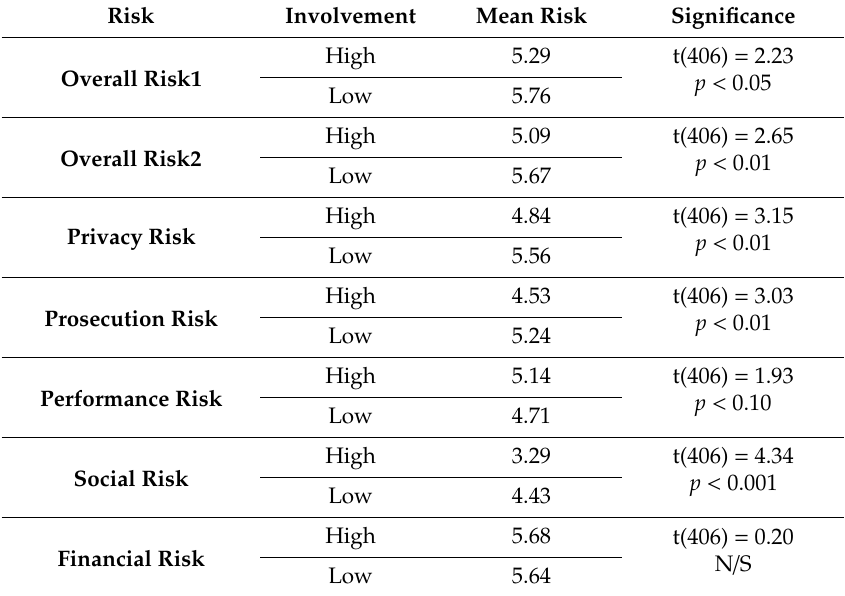
Table 12. Mean risk